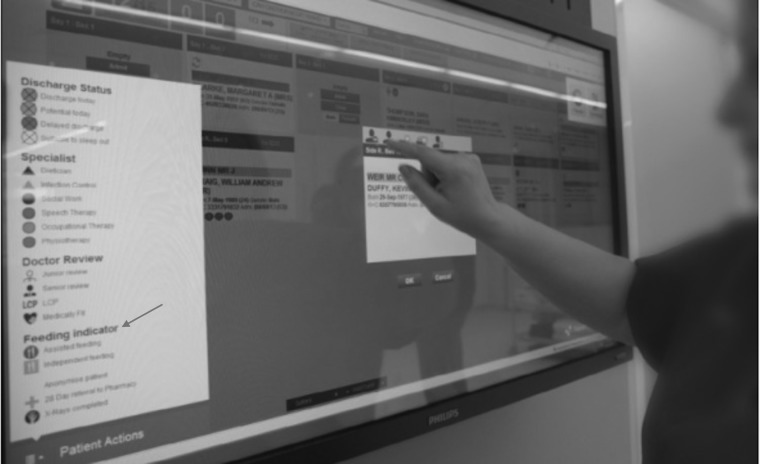
Patient flow board.